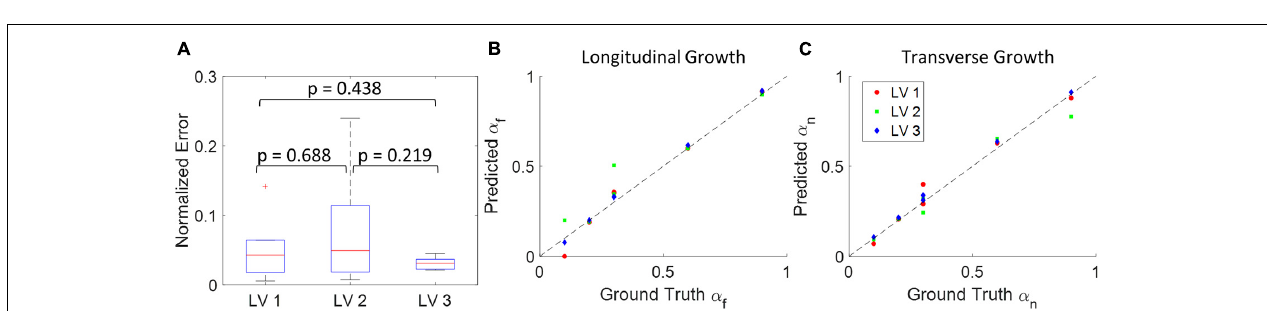
FIGURE 5 | Quantitative analysis of the results from 18 synthetic experiments. (A) Boxplot of normalized error across different subjects. (Boxplots show median, interquartile ranges, and whiskers show range. P -values were calculated using standard t -test). (B) Scatter plot of predicted longitudinal growth vs. ground truth longitudinal growth. (C) Scatter plot of predicted transverse growth vs. ground truth longitudinal growth. Dash lines in panels (B,C) indicate the identity line where predictions with zero error should locate